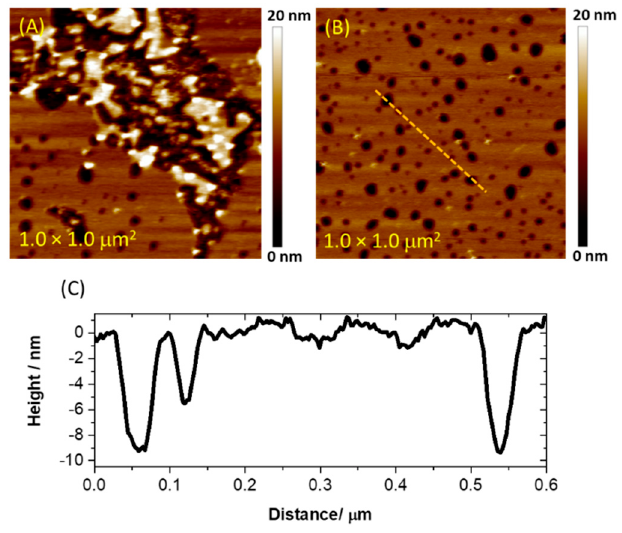
Figure 2. Atomic force microscopy (AFM) images collected for thioglucose-modified Au(111) after ( A ) 10 min and ( B ) 90 min of deposition of bicelles. Panel ( C ) presents the cross-sectional profile for the completed lipid assembly. The profile was taken along the orange dotted line displayed in panel ( B ). The images were collected in Peak Force Tapping mode.